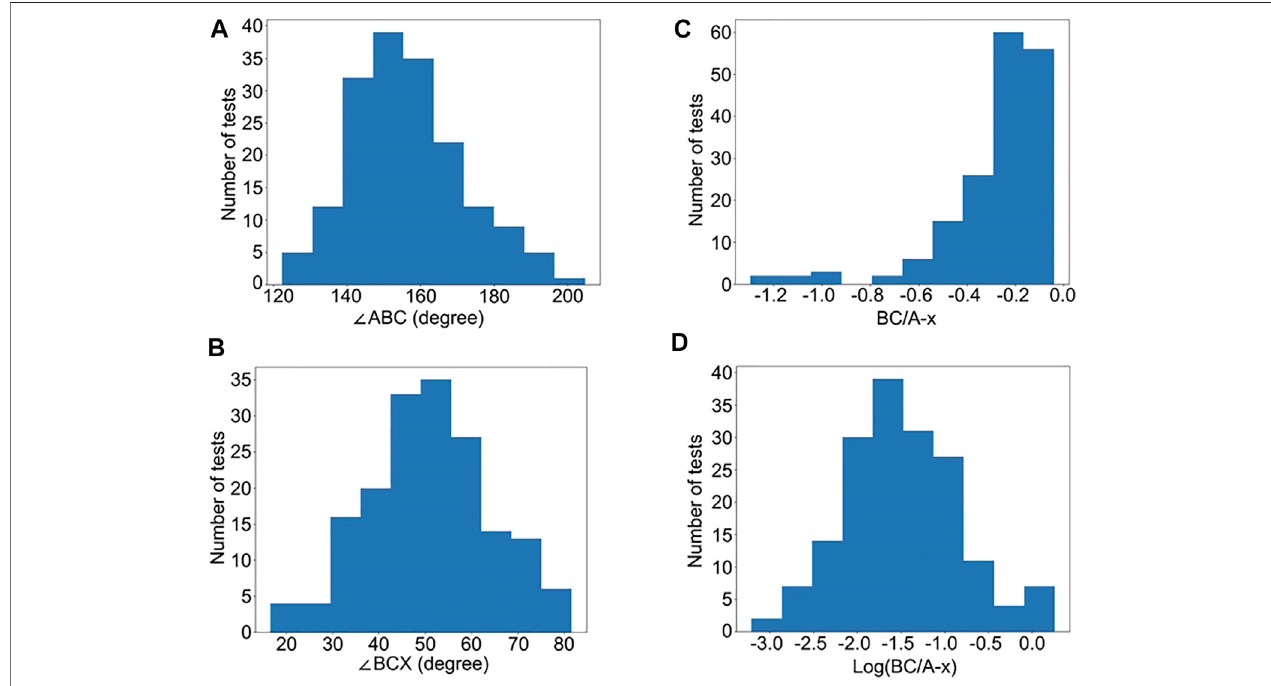
FIGURE 3 | Histogram distributions of ∠ ABC, ∠ BCX, BC/A-x, and log (BC/A-x). The distributions of ∠ ABC (A) and ∠ BCX (B) are close to Gaussian while the distribution of BC/A-x (C) is skewed to the right. After log transformation, the distribution of log (BC/A-x) approximated Gaussian (D) .